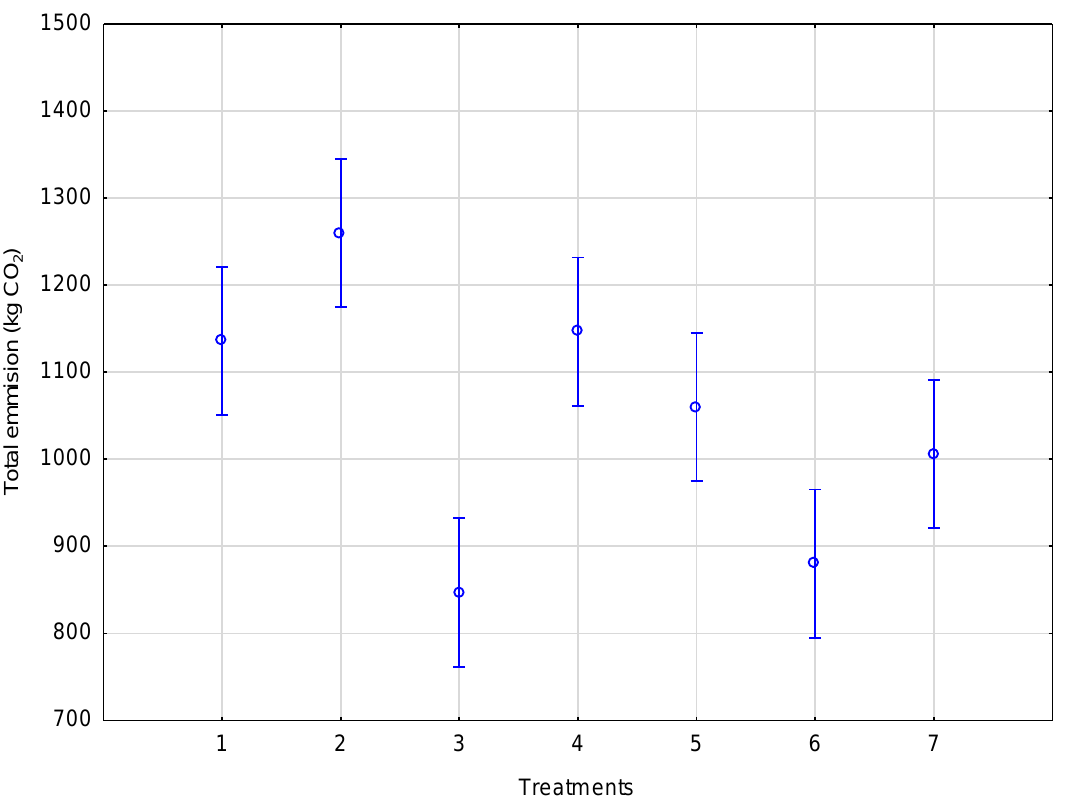
Figure 4. Average values of total emissions of 1 kg CO 2 depending on the type and dosage of biochar. The lowest value of this parameter was obtained for the object with 60 Mg of sun- flower husk biochar. The GHG emission value for the control object without biochar was 1136 kg CO 2 /Mg. From the point of view of environmental efficiency, the best effects for the adopted system boundary were obtained in the variant with the addition of 60 Mg of biochar, both when the raw material was sunflower husk and wood chips. A further